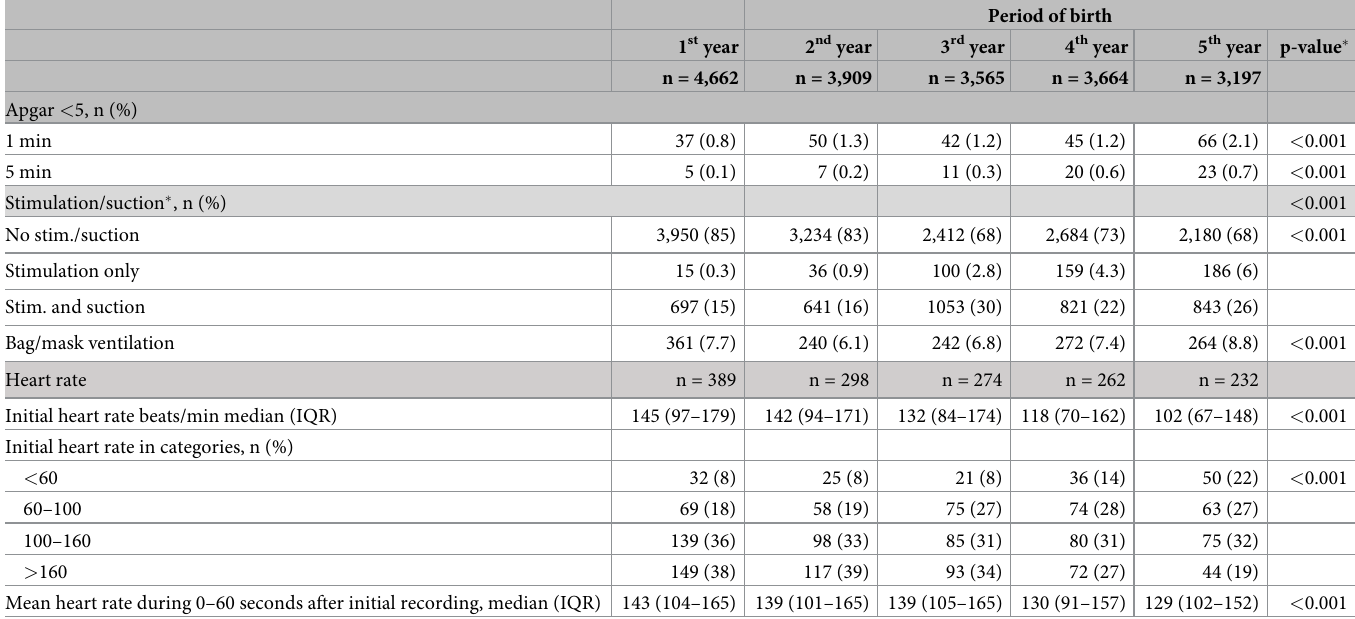
Table 2. Postnatal events and heart rate recordings of live births at Haydom 1.7.2013–30.6.2018 (n =